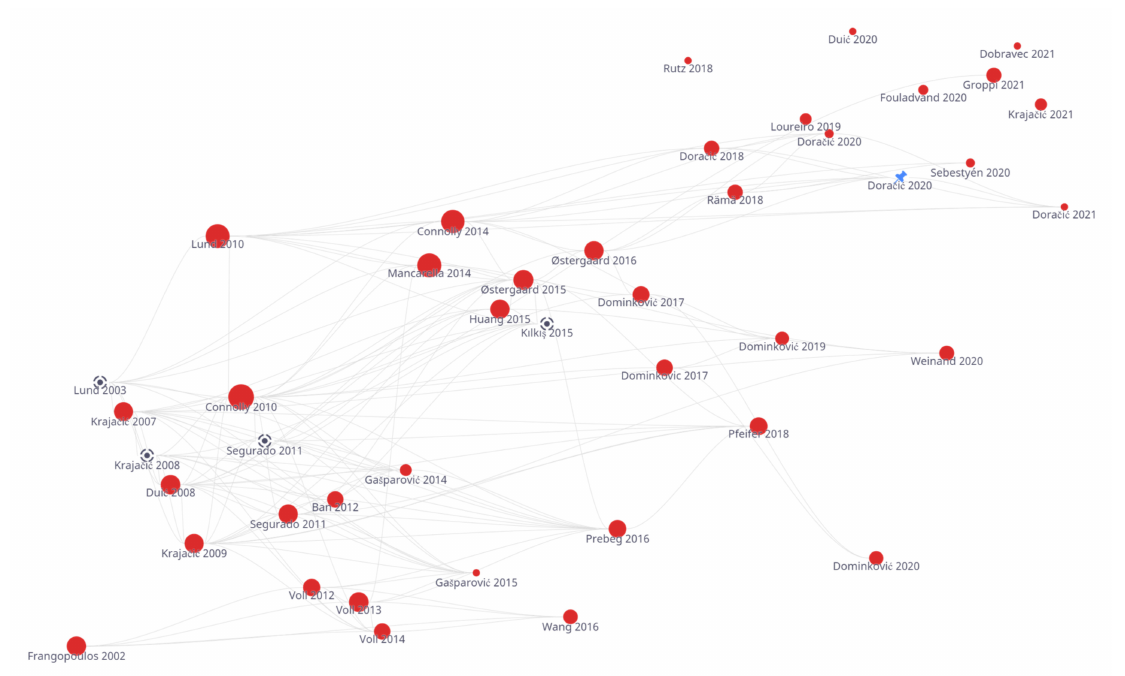
Figure 4. Overview model of the snowball-effect research methodology, considered in the present